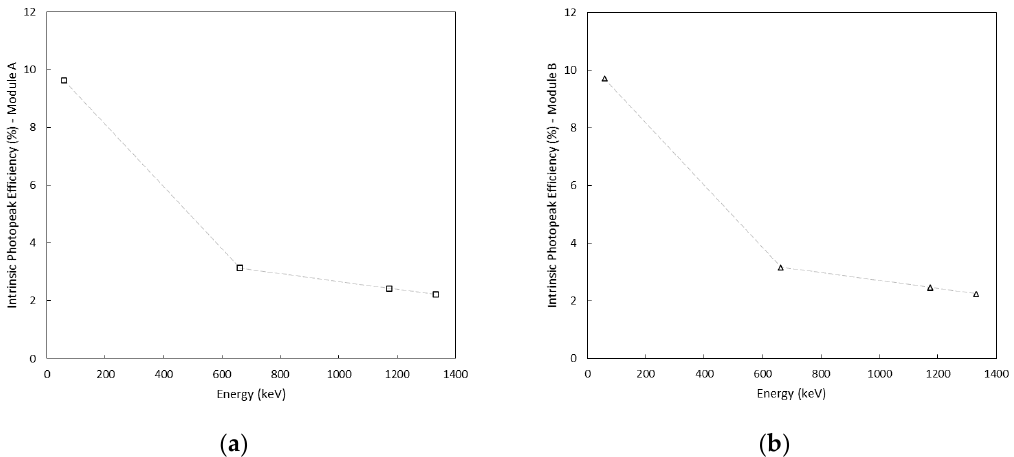
13 of 19 Figure 11. Setup of the measurements performed to investigate the energy dependence of the in- trinsic photopeak efficiency of the detectors. Table 3. Characteristics of the exposures performed to investigate the energy dependence of the intrinsic photopeak efficiency of the detectors . Emitter